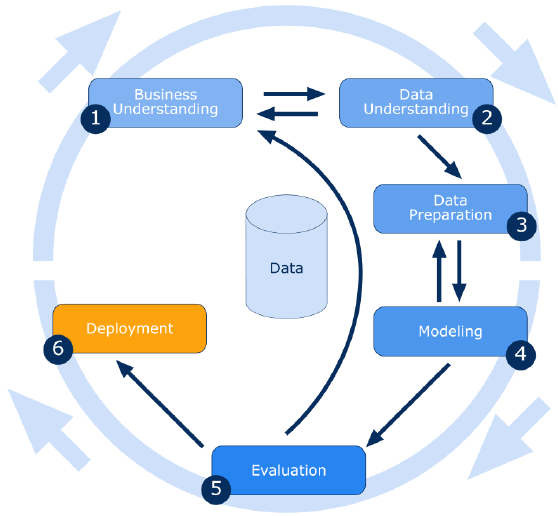
Fig. 2. Data mining